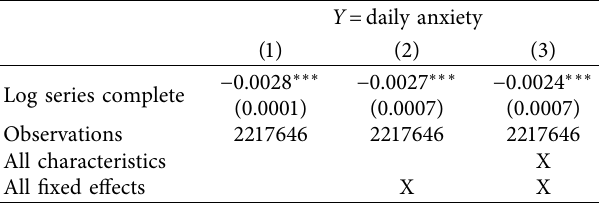
Table 2: Vaccination and anxiety.